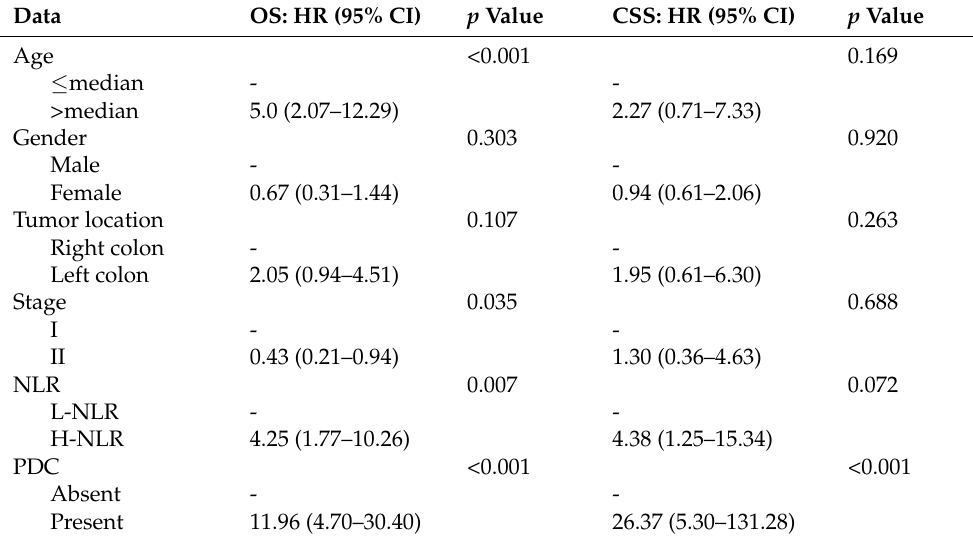
Table 3. Multivariable analysis for overall- and cancer-specific survival.